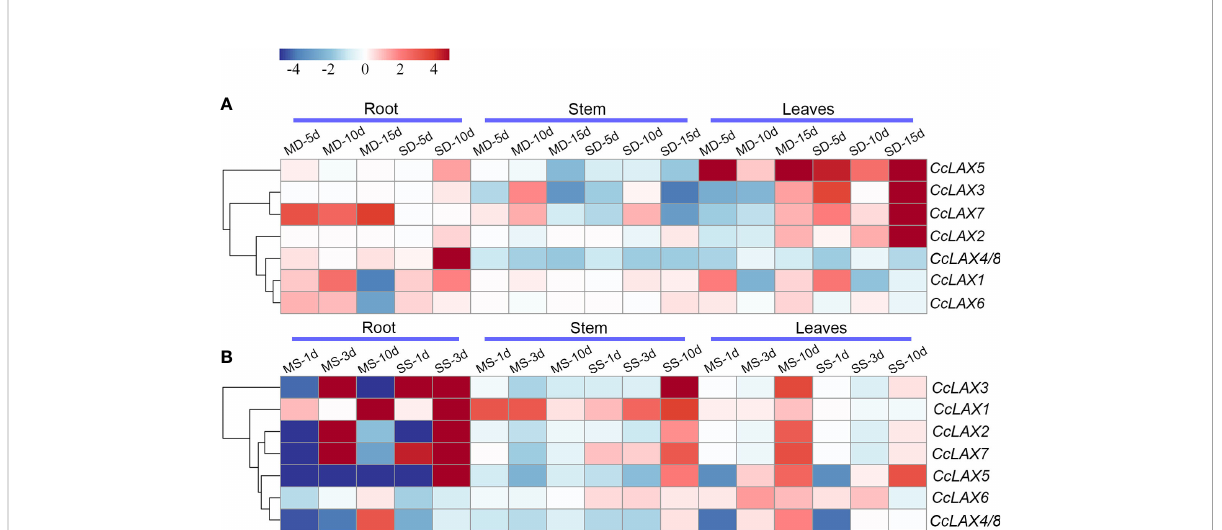
FIGURE 6 Expression patterns of putative CcAUX/LAX genes in Chinese hickory under drought and salt treatments. (A) Expression pro fi les of CcAUX/LAX family genes in roots, stems and leaves under mild drought stress (50g·L -1 PEG) and severe drought stress (200g·L -1 PEG) treatments for 5 days, 10 days and 15 days, respectively (B) Expression pro fi les of CcAUX/LAX family genes in roots, stems and leaves under mild salt stress (50 mM NaCl) and severe salt stress (150 mM NaCl) treatments for 1 days, 3 days and 10 days, respectively. MD-5d, mild drought stress treatment for 5